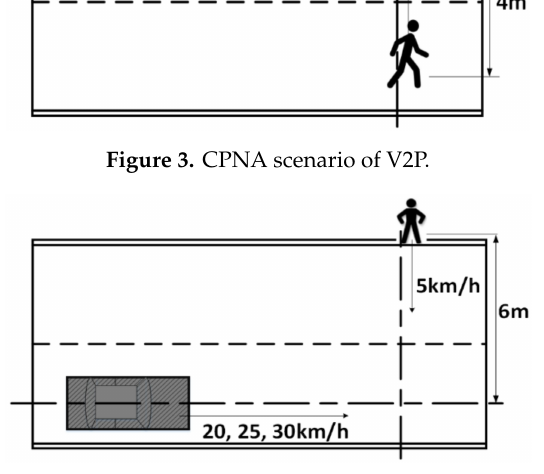
Figure 4. CPFC scenario of V2P.